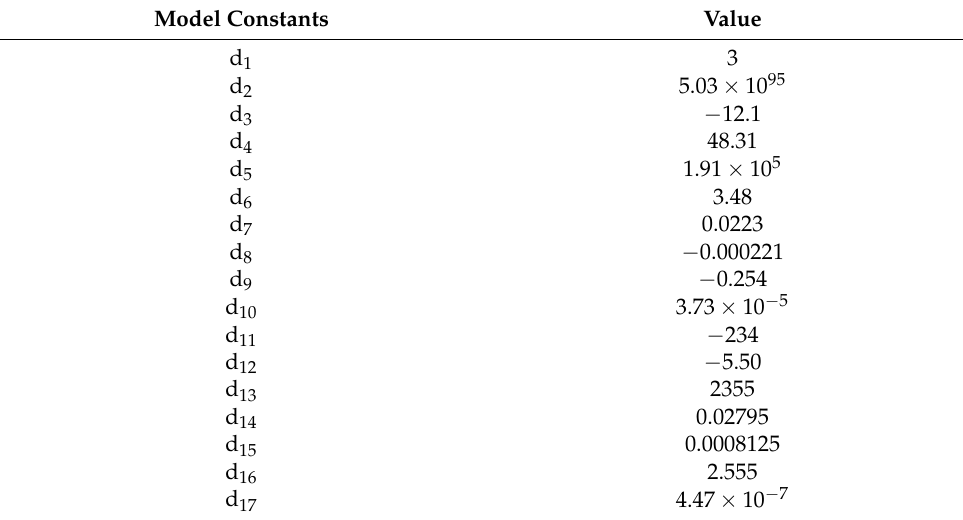
Table 3. Tuning constants for the physics-based BD model. Model